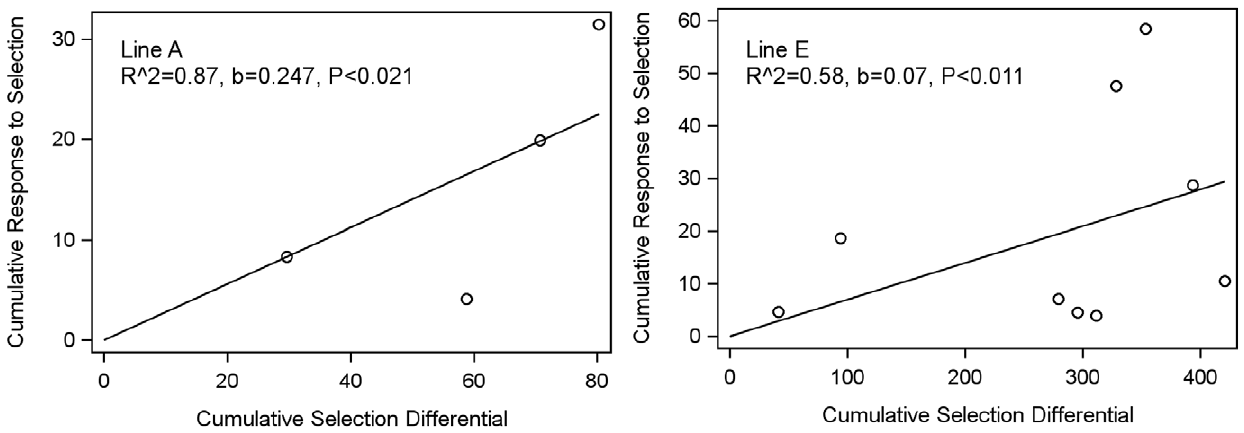
Figure 5. Response of An.stephensi selected for susceptibility to P.gallinaceum based on mean oocyst load. The cumulative response to selection is regressed on the cumulative selection differential for the selected An. stephensi lines. Regression is forced through the origin.